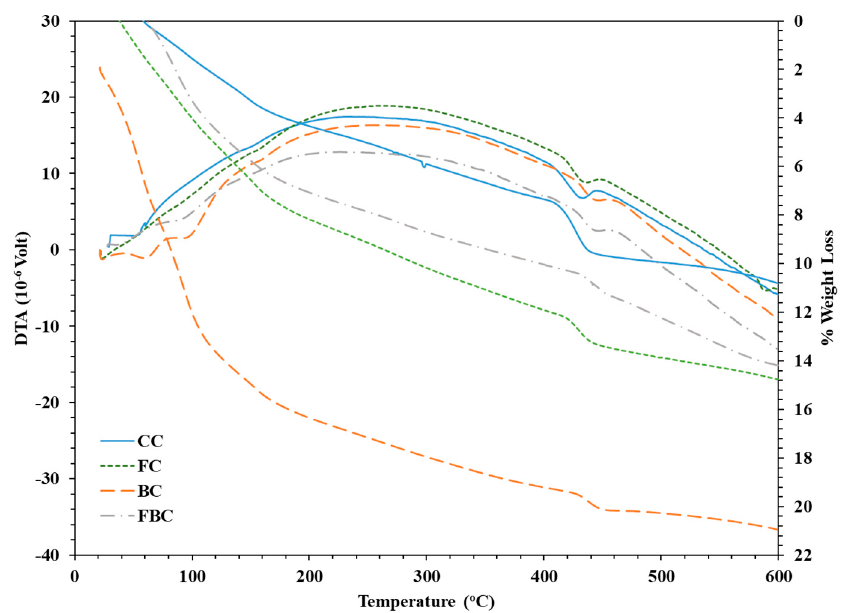
Figure 9. TGA/DTA of mass concrete specimens containing mineral additives at 28 days.